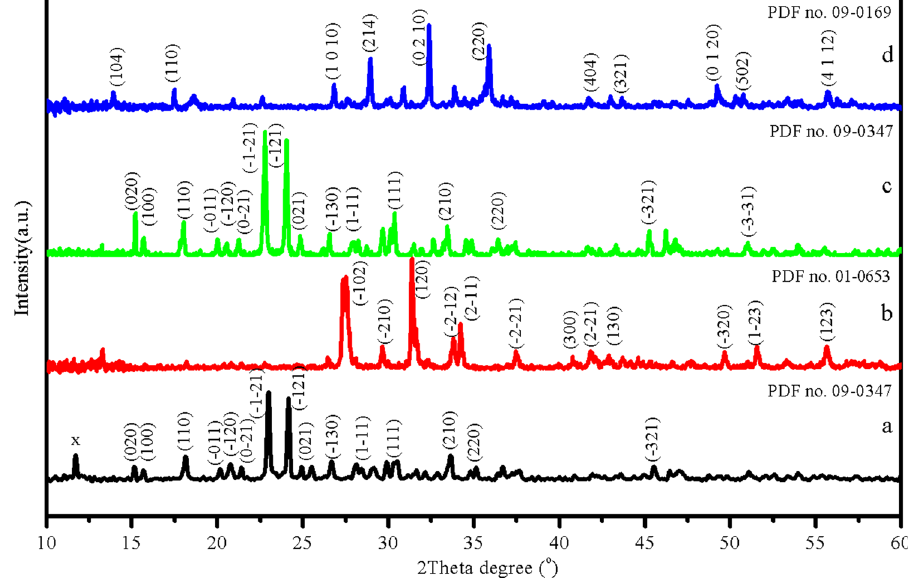
Figure 3. X-ray diffraction patterns of triple superphosphate (a), dicalcium phosphate dihydrate (b), monocalcium phosphate monohydrate (c), and tricalcium phosphate (d).